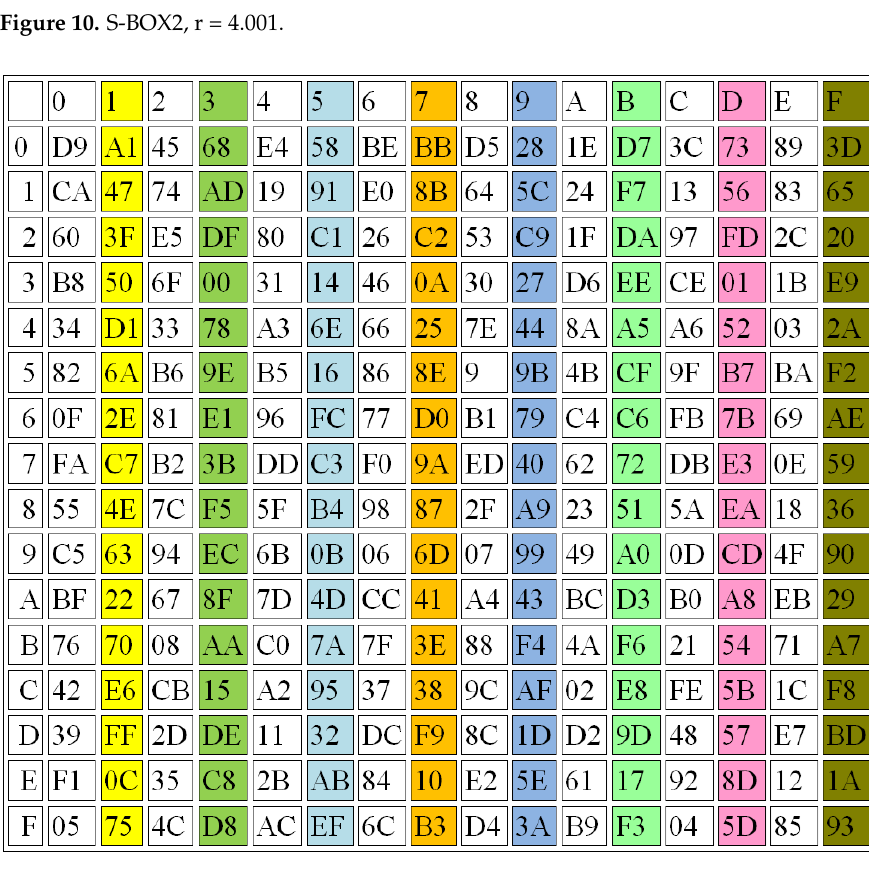
Figure 11. S-BOX3, r =